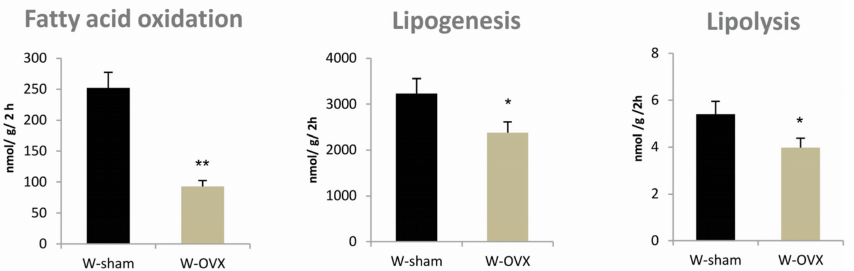
Figure 3. Substrate utilization in interscapular brown adipose tissue: fatty acid oxidation, lipogenesis and lipolysis in ovariectomized Wistar female rats compared to sham-operated controls. Significance